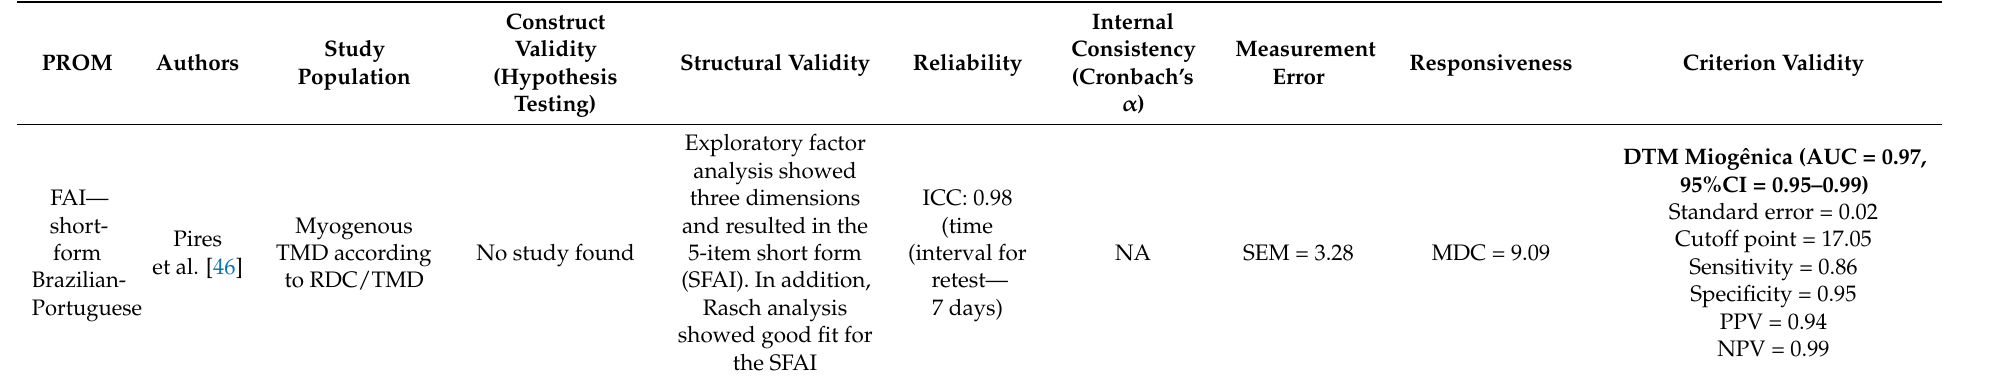
Table 8. Summary of the measurement properties of Short-Form Fonseca Anamnestic Index